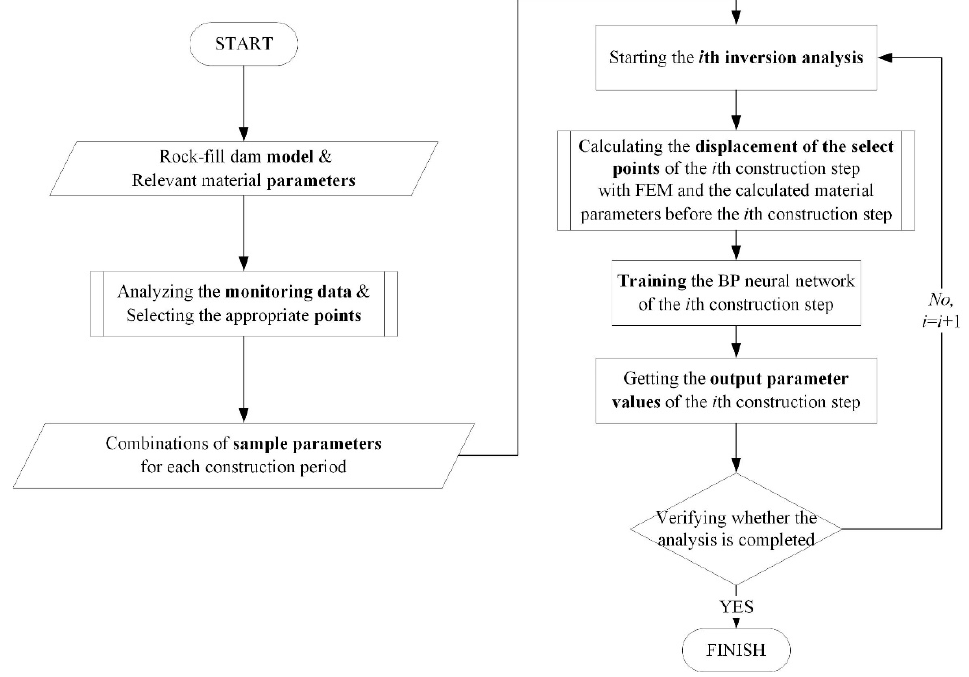
Figure 2. Flowchart of step-by-step inversion method.